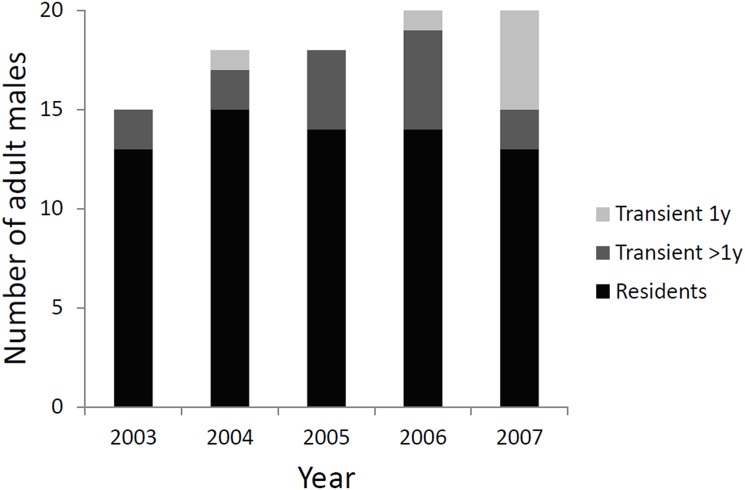
Number of male jaguars detected each survey (2003–2007), separated into ‘residents’ and ‘transients’.Residents were defined as detected ≥ 3 consecutive years (black). We separated transients into two parts, 2 consecutive years of detection (dark grey), 1 year of detection (light grey).